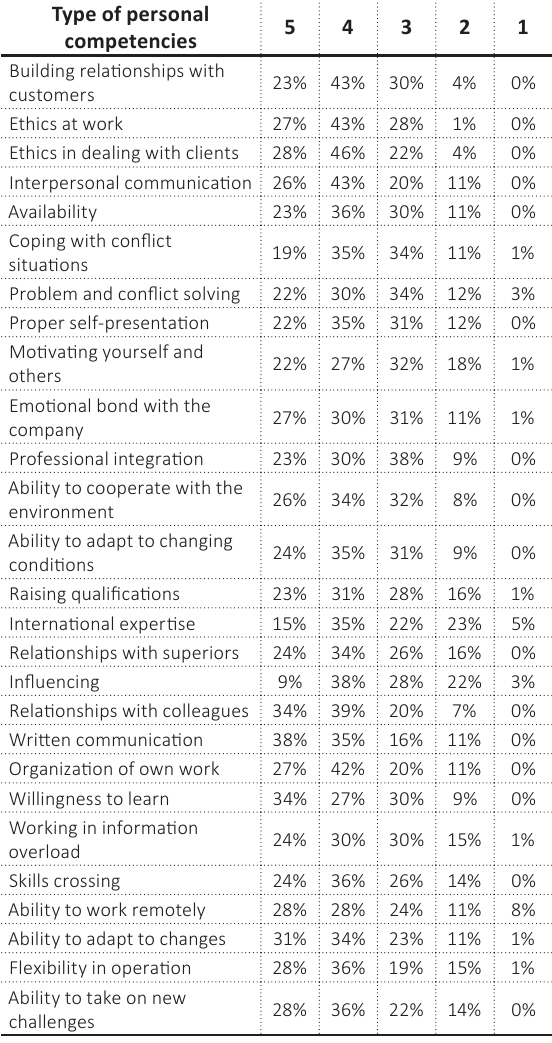
Table 8. Personal social competencies